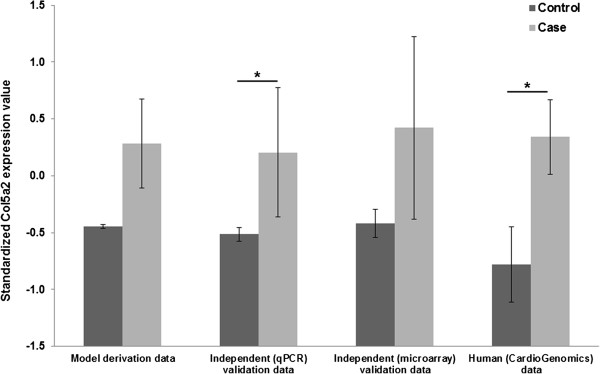
Col5a2 expression values in multiple independently generated datasets. * denotes significant differences between mean values observed in control and case groups at the P = 0.05 level. Vertical bars represent 95% confidence intervals. Case groups represent disease categories.